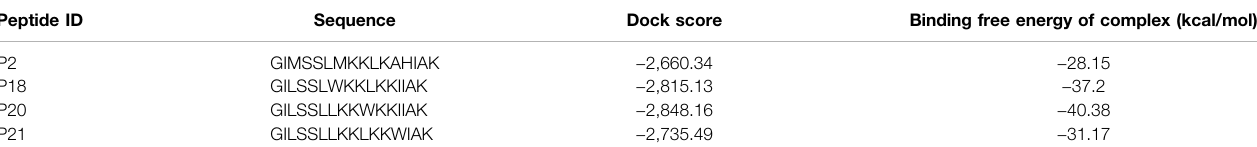
TABLE 1 | The binding free energy and the dock score of the best four peptide molecules; P2, P18, P20, and P21 Peptide ID